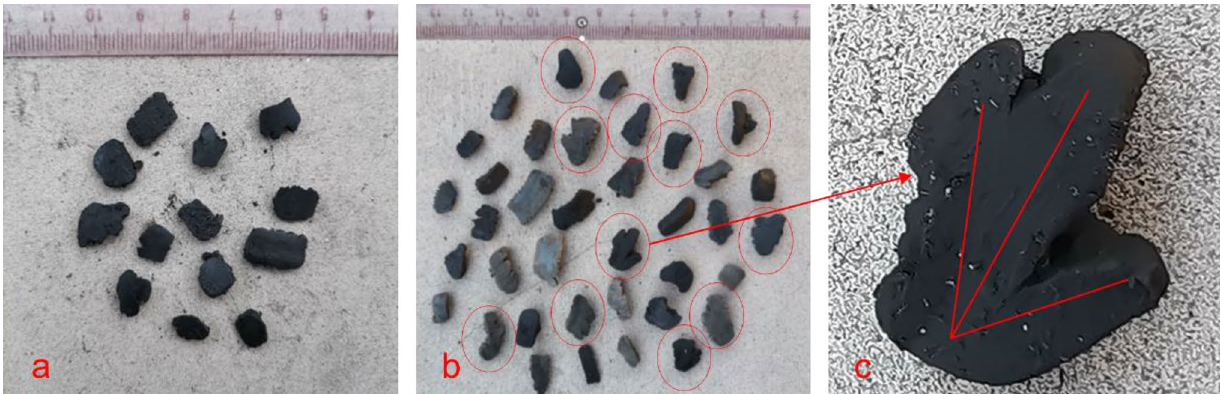
Fig. 24 Comparison of the cutting size between flat cutter and 3D concave-shaped cutter: a Field cutting size of the flat cutter bit; b Field cutting size of the 3D concave-shaped cutter bit; c Trilobal cutting of the 3D concave-shaped